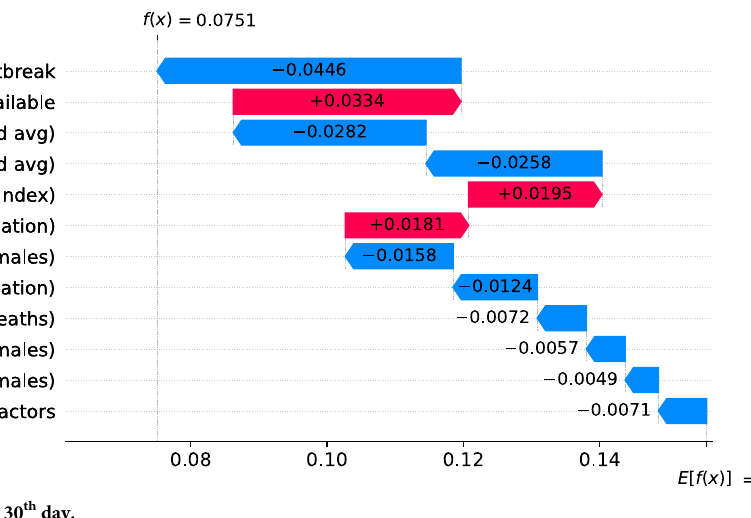
Fig 35. (Color online) factors driving velocity in Brazil on the 30 th day.